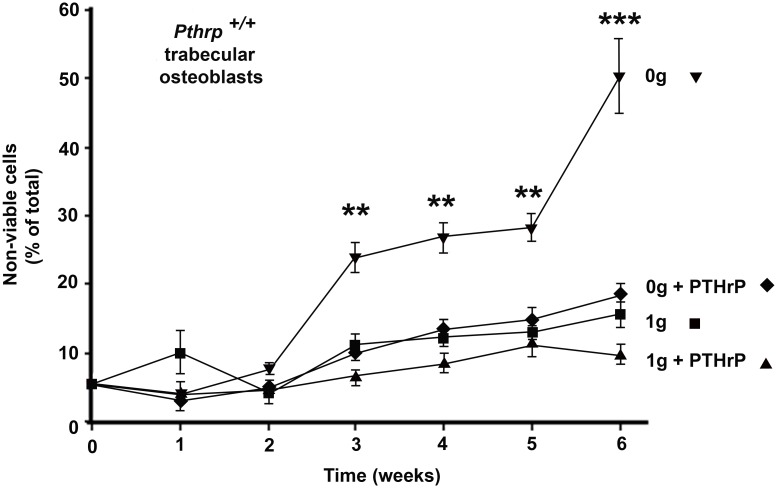
Long-term exposure to simulated microgravity is detrimental to wild-type trabecular osteoblasts but compensated for by exogenous intermittent PTHrP1-36 treatment.Pthrp+/+ trabecular osteoblasts at 1g (■) or 0g (▼). Pthrp+/+ trabecular osteoblasts treated with PTHrP1-36 10-8M.at 1g (▲) or 0g (♦). (triplicate 6-week experiments). Viability estimated by Trypan blue. ** p < 0.01, *** p < 0.001.